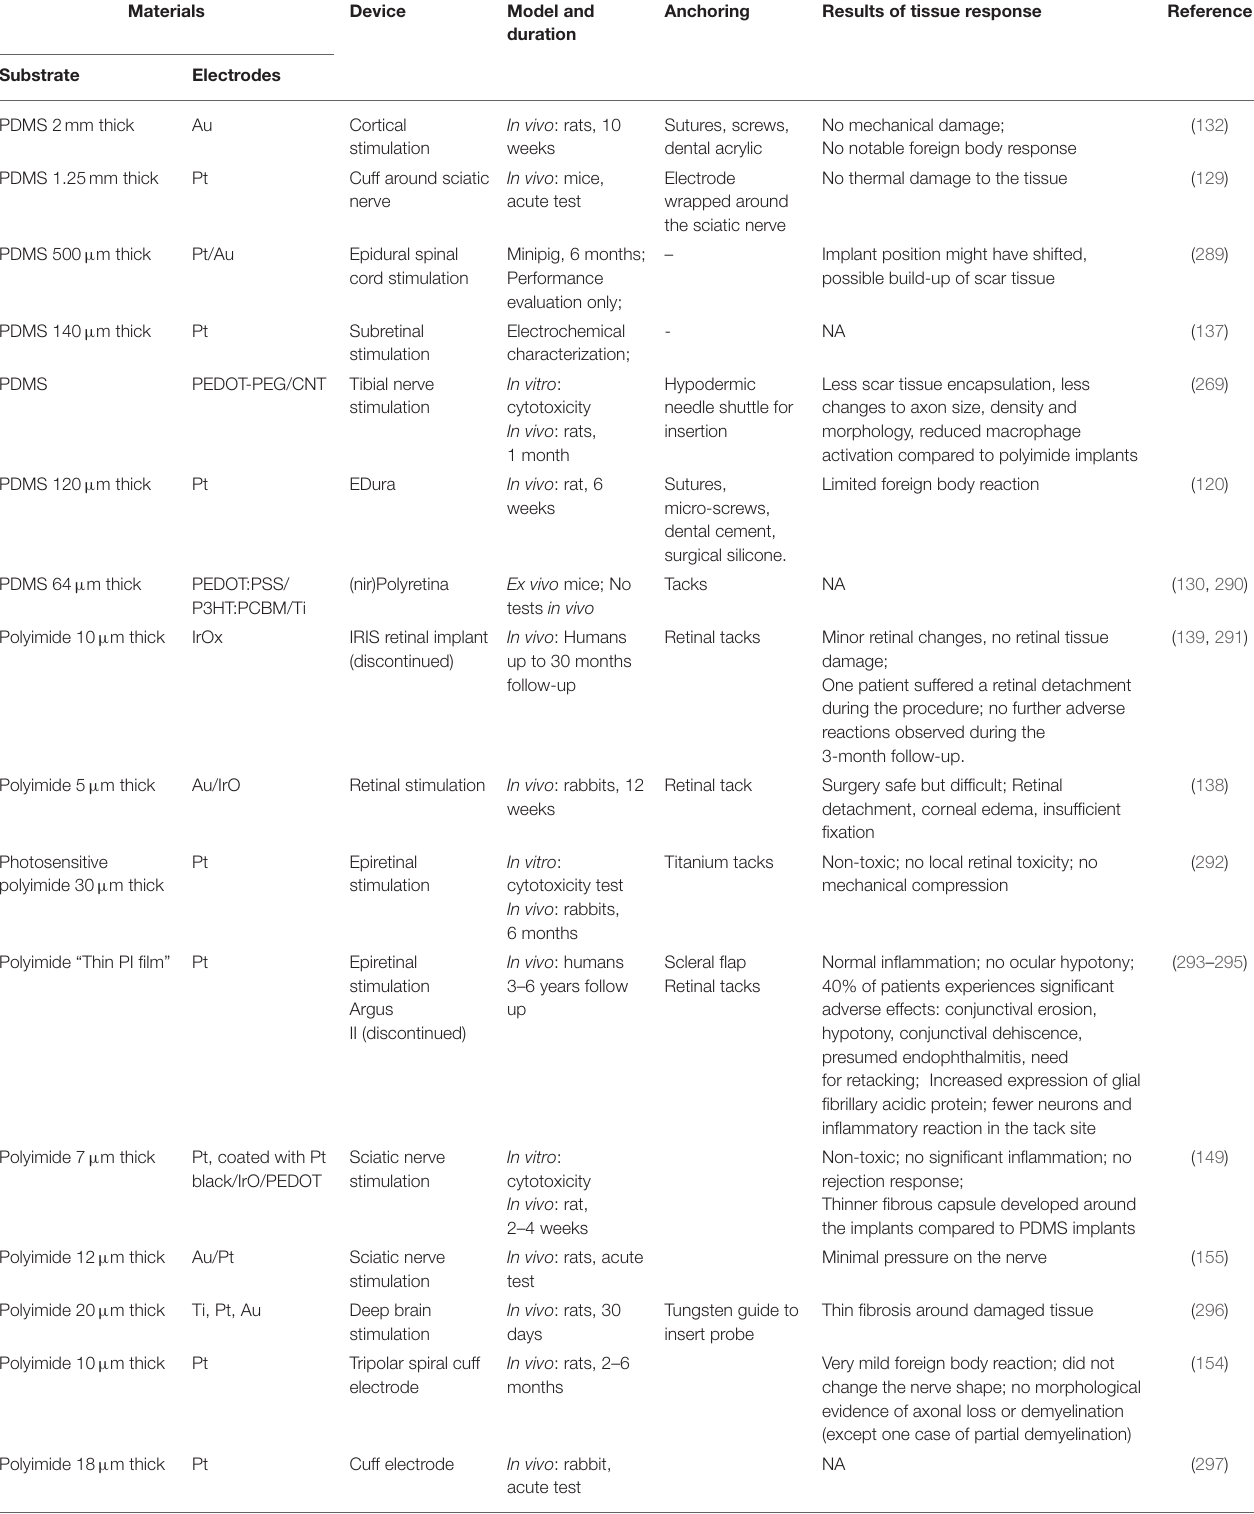
TABLE 2 | Flexible devices for neural